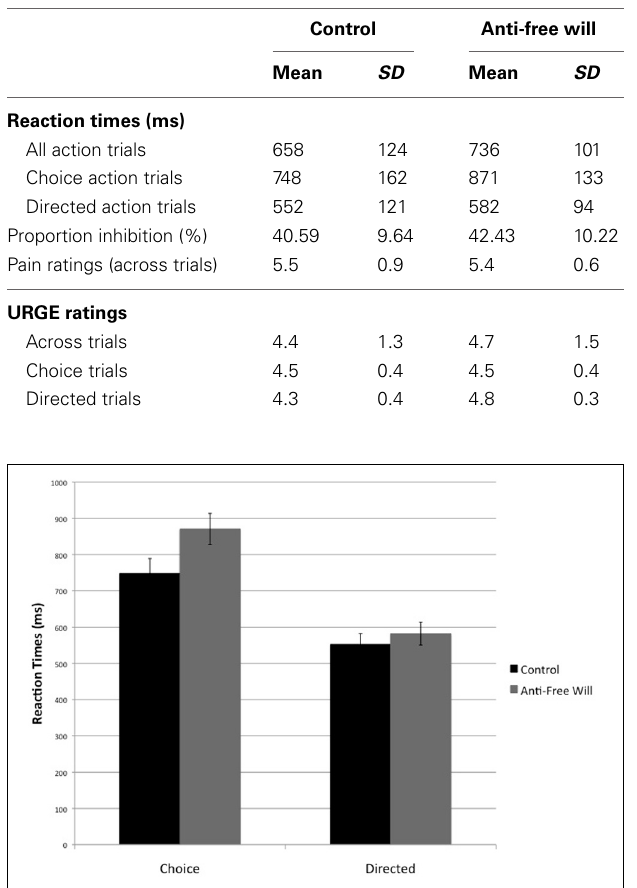
FIGURE 3 | Reaction times on press trials, between-subjects. Note: values depicted are means and standard errors.